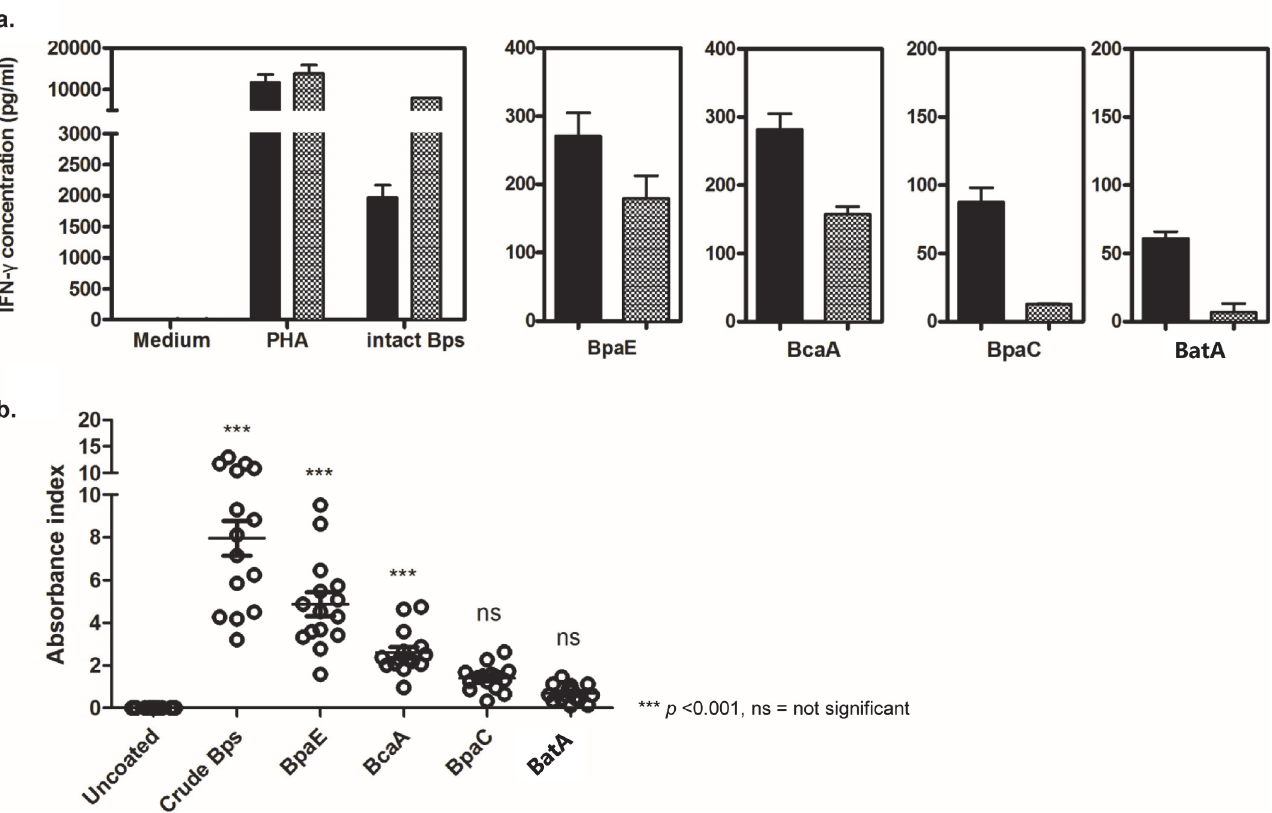
Fig 5. Immune recognition of recombinant proteins. a) Recombinant N-terminal GST fusion proteins of the passenger domain of four ATs were used as antigens (1 μ g/ml) to stimulate whole blood (WB) from human seropositive donors, alongside PHA and fixed B . pseudomallei strain K96243 positive controls. The IFN- γ response of WB was measured by ELISA. BpaE and BcaA (225.4 pg/ml ± 45.7 pg/ml and 214 pg/ml ± 56.7 pg/ml respectively; p value < 0.001) relative to the medium-only control average (4.99 pg/ml ± 1.7 pg/ml) elicited a strong IFN- γ response from WB from seropositive donors (n = 2; black and grey bars represent the two individual donors) while BpaC and BatA did not induce a significant lymphocyte recall response. b) The four antigens were also tested for recognition by human seropositive sera from a melioidosis endemic area using an indirect sandwich ELISA. BpaE and BcaA (absorbance index of 7.96 ± 0.82 and 4.86 ± 0.55 respectively; p value < 0.001) were both recognised by seropositive human sera from the endemic area while values for neither BpaC nor BatA were significantly different from the negative control.